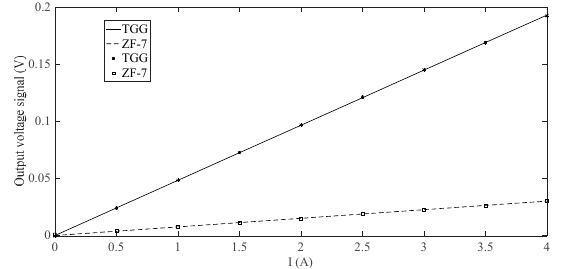
Figure 7. Error comparison. Figure 8. Measurement curves of TGG and ZF-7.